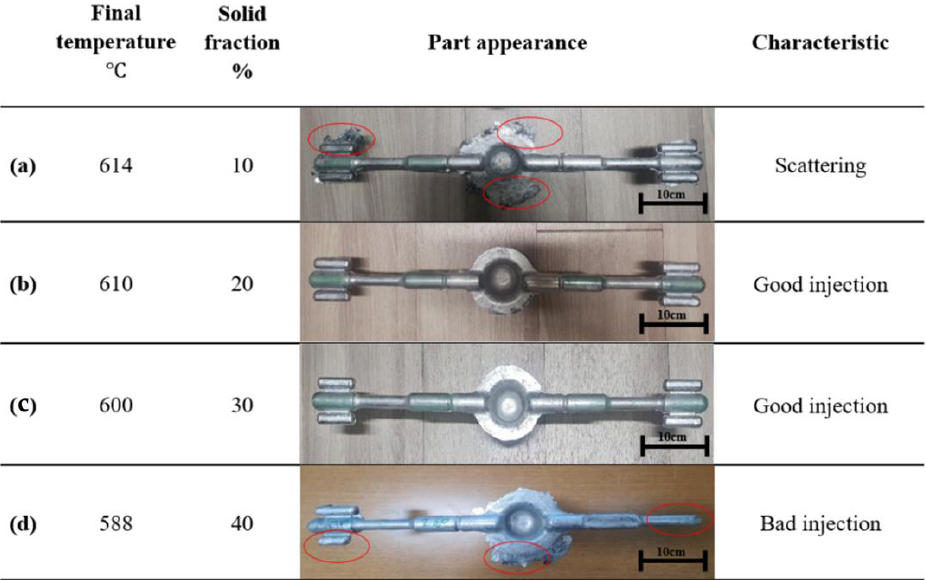
Figure 5. Castability according to solid fraction: ( a ) T = 614°C, 𝑓𝑠 = 10%, ( b ) T = 610 °C, 𝑓𝑠 = 20%, ( c ) T= 600 °C, 𝑓𝑠 = 30%, ( d ) T = 600 °C, 𝑓𝑠 = 40%.